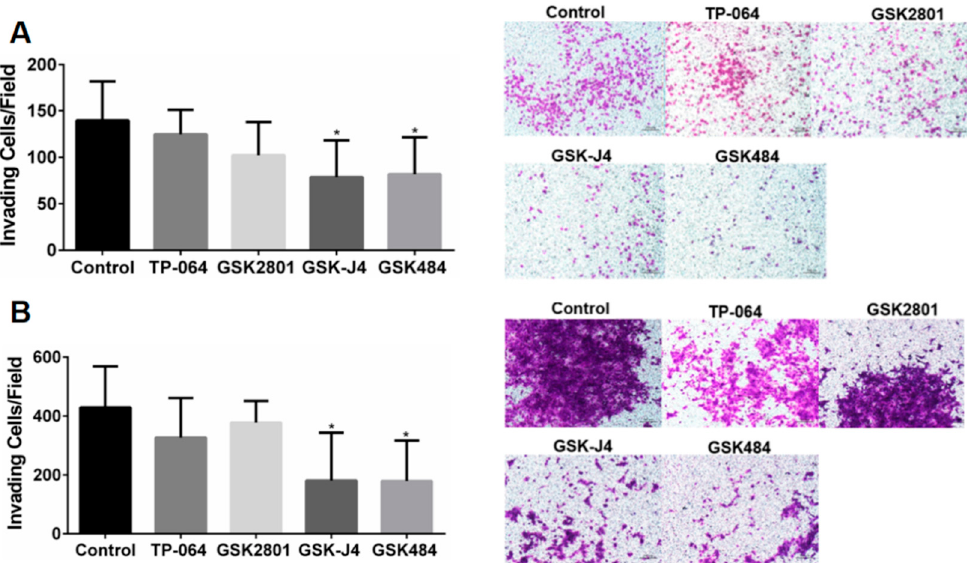
Figure 2. ( A ) Analysis of cell invasiveness after treatment with epigenetic molecules in the A549 cell line. ( B ) Analysis of cell invasiveness after treatment with epigenetic molecules in the H1568 cell line. Transwell invasion test evaluated after 48 h (* p < 0.05, One-way ANOVA followed by Student’s t-tests).